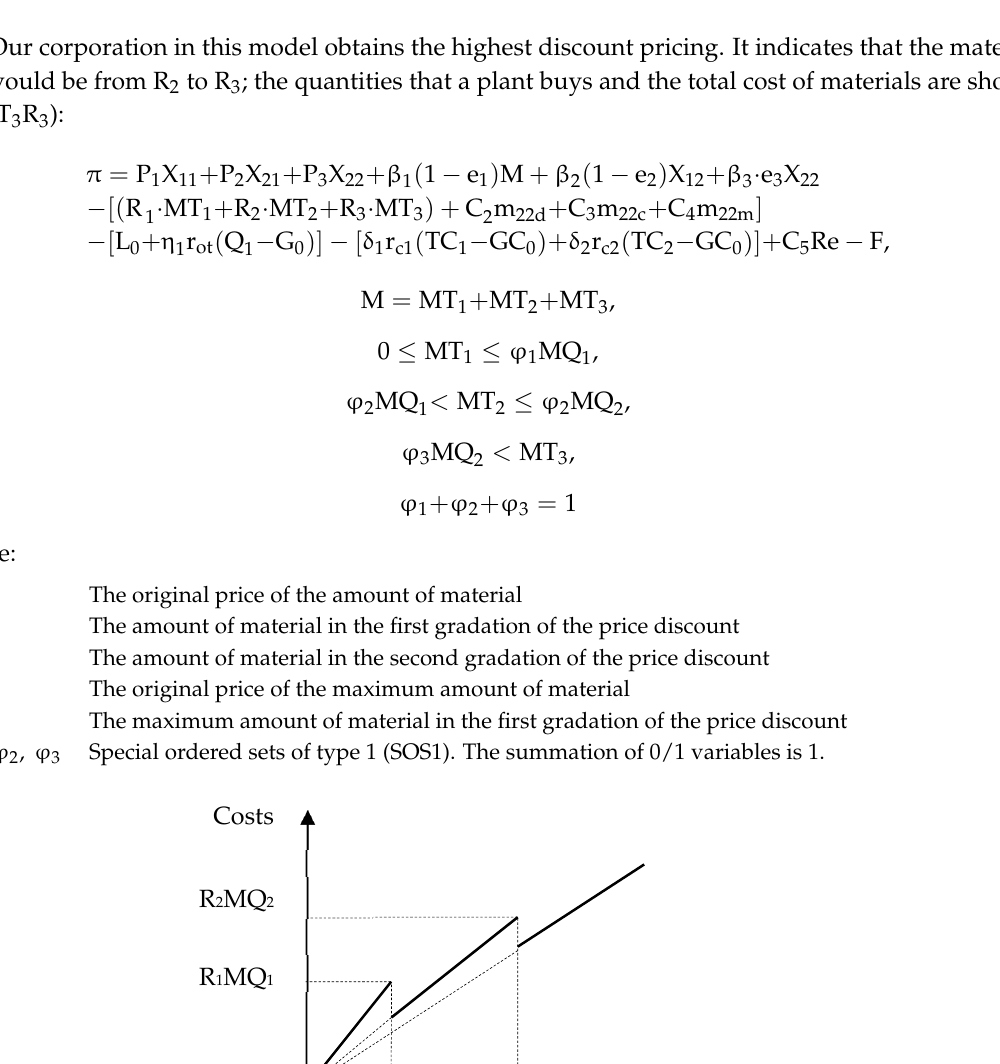
Table 4. The optimal solution in mixed integer programming model (MIP).